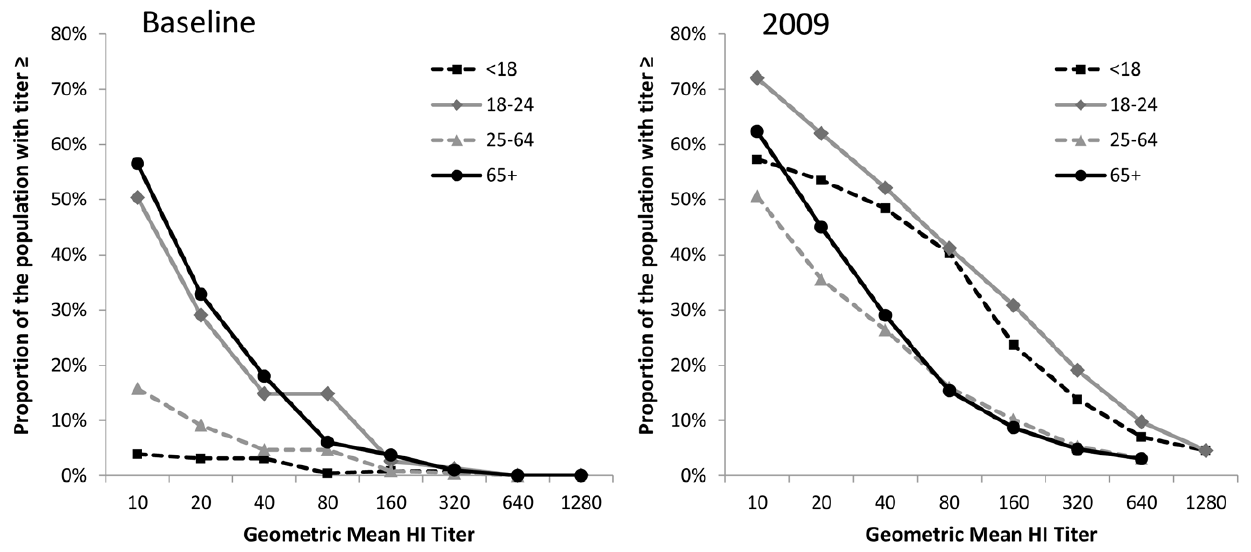
Figure 2. Comparison of the reverse cumulative distribution of HI titers between baseline and 2009 serum specimens, by age group.